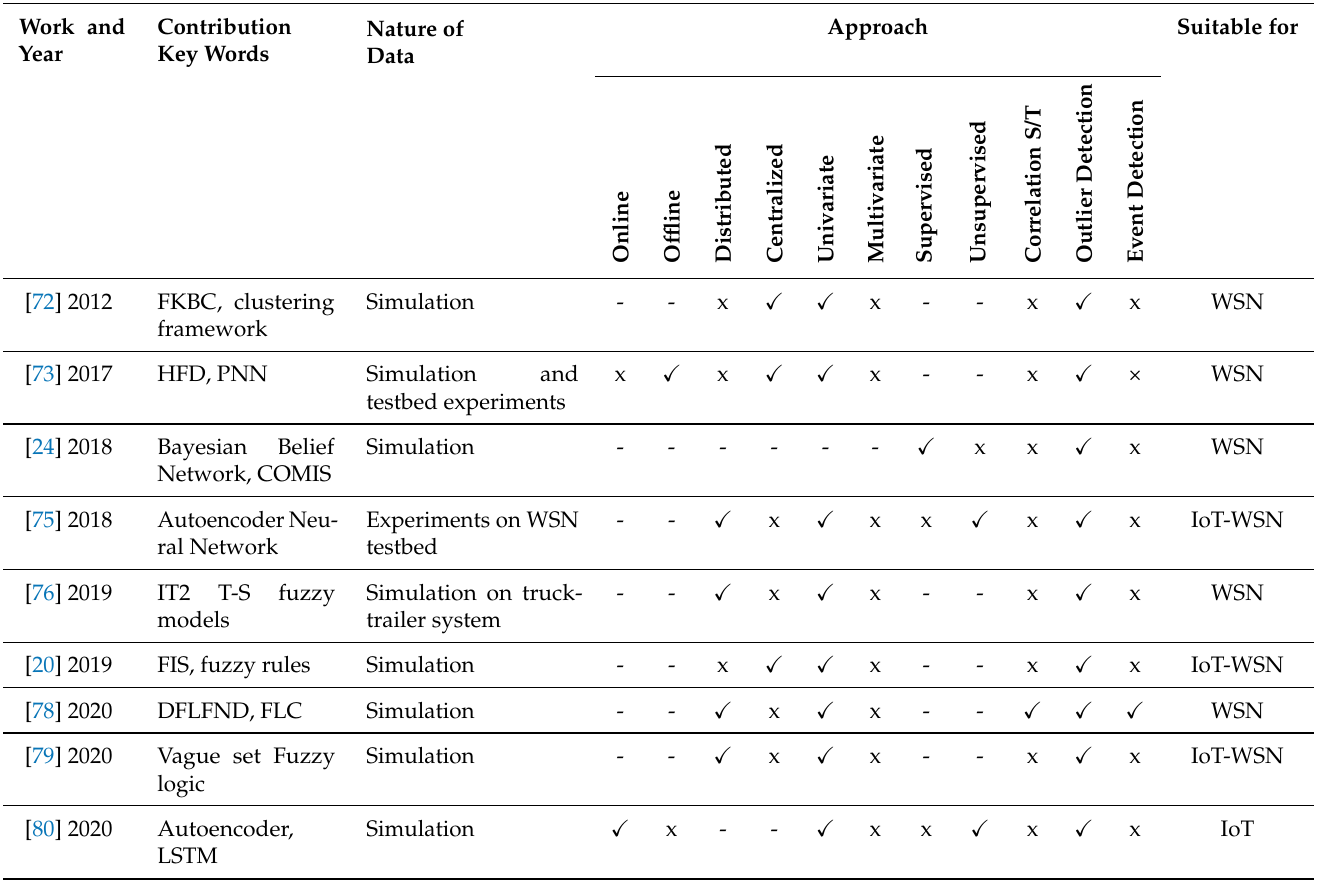
Table 6. Comparative Table of AI Based